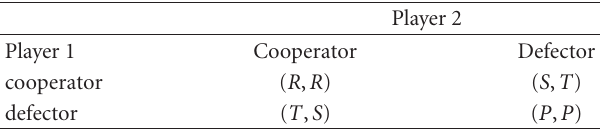
Table 1: Payo ff